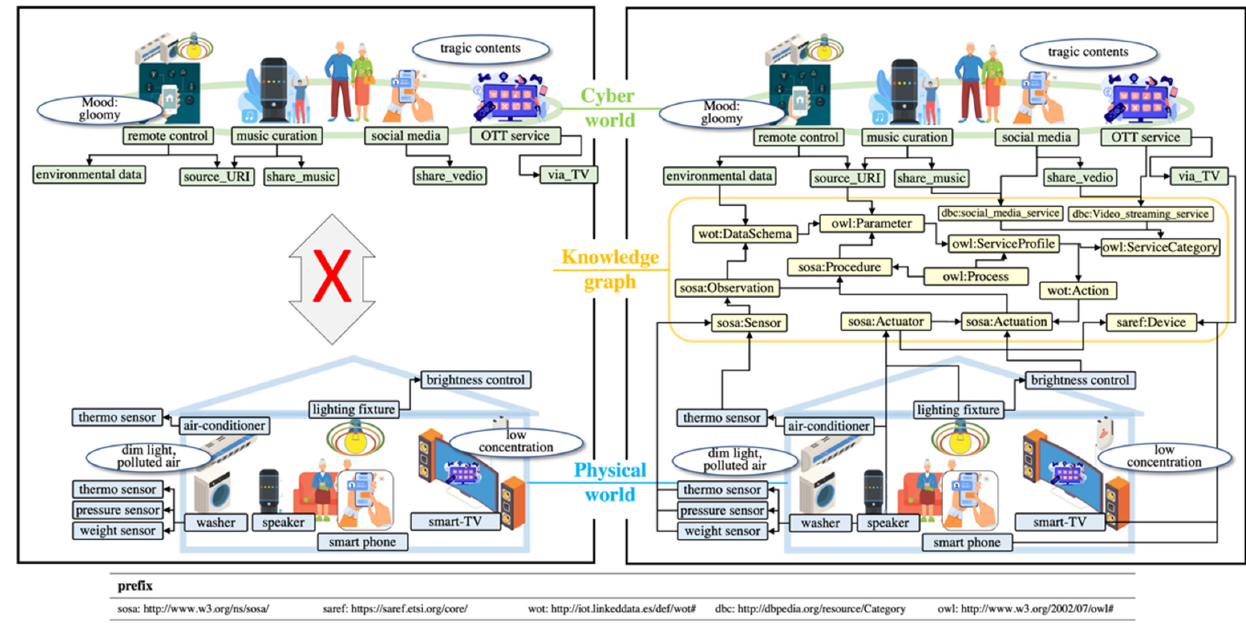
Figure 1. Illustrative example of a knowledge graph-based cyber–physical view